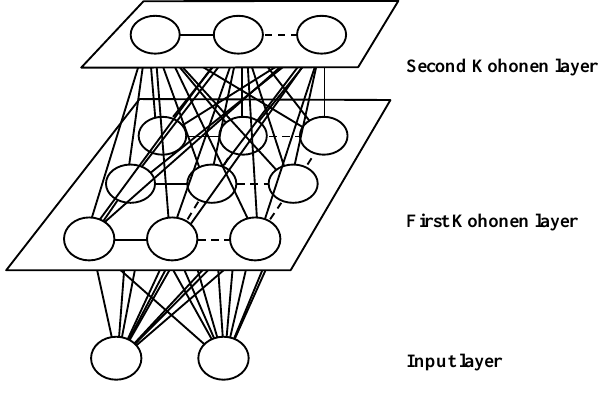
Figure 2. The architecture of two-layer neural network for air quality data mining. Reprinted from [48], with permission from Elsevier.